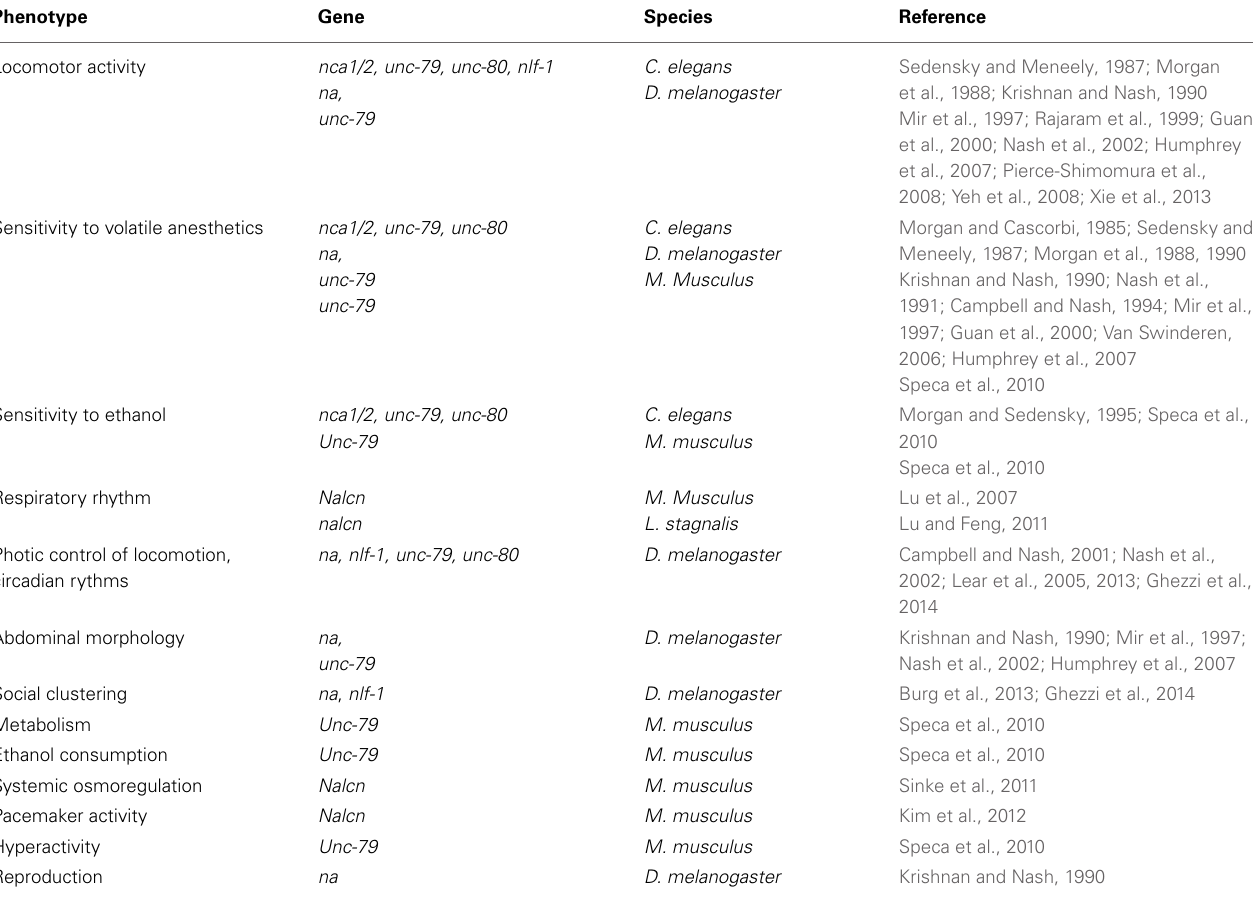
Table 2 | Physiological roles of NALCN: lessons from animal